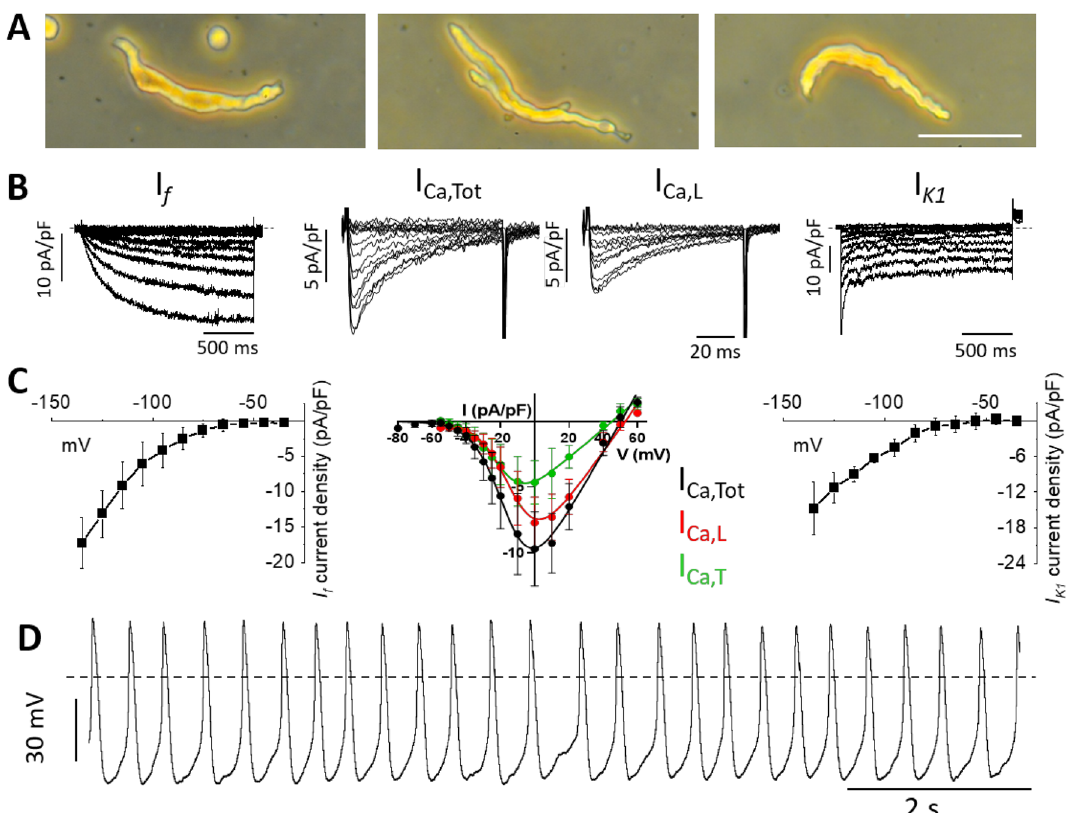
Figure 4. Recordings of ionic currents in SAN myocytes of GML. ( A ) Freshly isolated pacemaker myocytes obtained from the GML SAN tissue (scale bar 50 µm). ( B ) Sample traces of I f , (n = 4, N = 2), total I Ca ( I Ca,Tot ) and I Ca,L (n = 4, N = 2) and I K1 (n = 3, N = 1). ( C ) Current-to-voltage relationships of densities of ionic currents described in panel ( A ) for I f , I Ca,Tot , I Ca,L , I Ca,T and I K1 , . ( D ) Action potentials (APs) recorded in SAN pacemaker myocytes from GML under perfusion of Tyrode’s